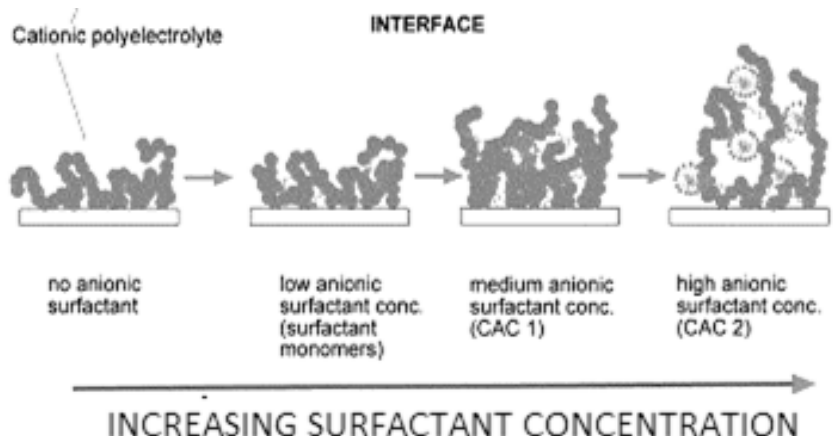
Figure 7. Different regions for the adsorption of polyelectrolyte–surfactant mixtures onto a solid surface as result of increasing surfactant concentration. Adapted from [84] , Copyright (2010), with permission from Elsevier.